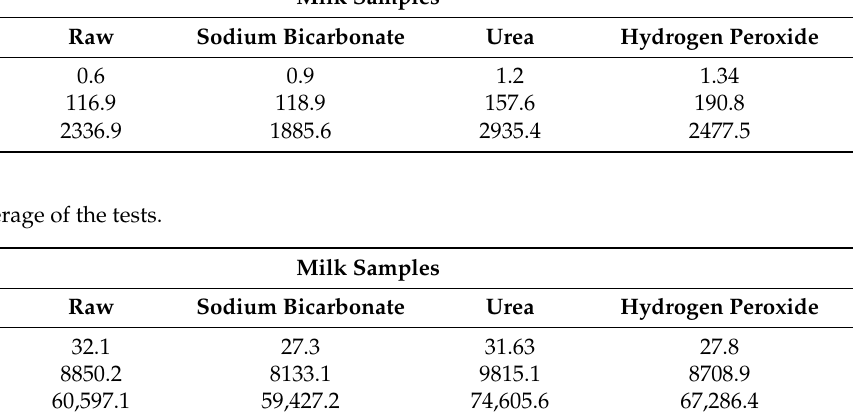
Figure 9. 3D representation of color maps for all contaminations ( a ) and 2D representation of color maps ( b – d ).